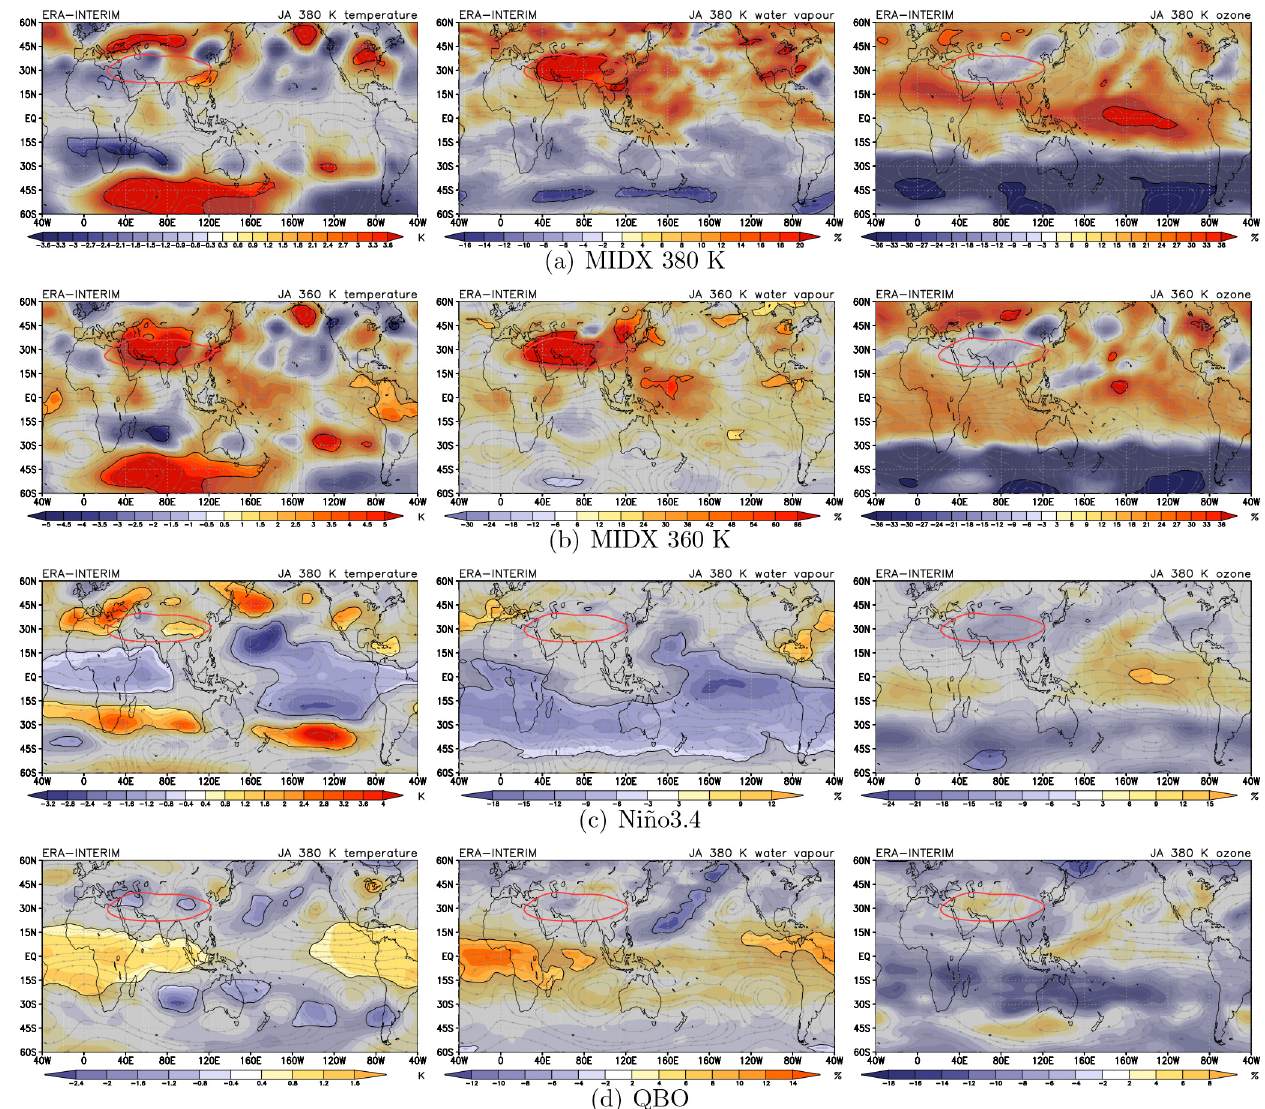
Figure 8. Regression coefficients from MLR of ERA-Interim data, for the monsoon circulation index (a) on 380K and (b) on 360K, (c) the Niño3.4 index, and (d) the QBO time series on the 380K isentropic level; temperature (left), water vapour (middle), and ozone (right). The regression coefficients for the H 2 O and O 3 mixing ratios are displayed in percent of the long-term average of the respective JA average. The red contour of the Montgomery stream function marks the position of the AMA: 3625 × 10 2 m 2 s − 2 on 380K, 3513 × 10 2 m 2 s − 2 on 360K. Overlaid grey shading marks regions where the regression is not significant at the 95%